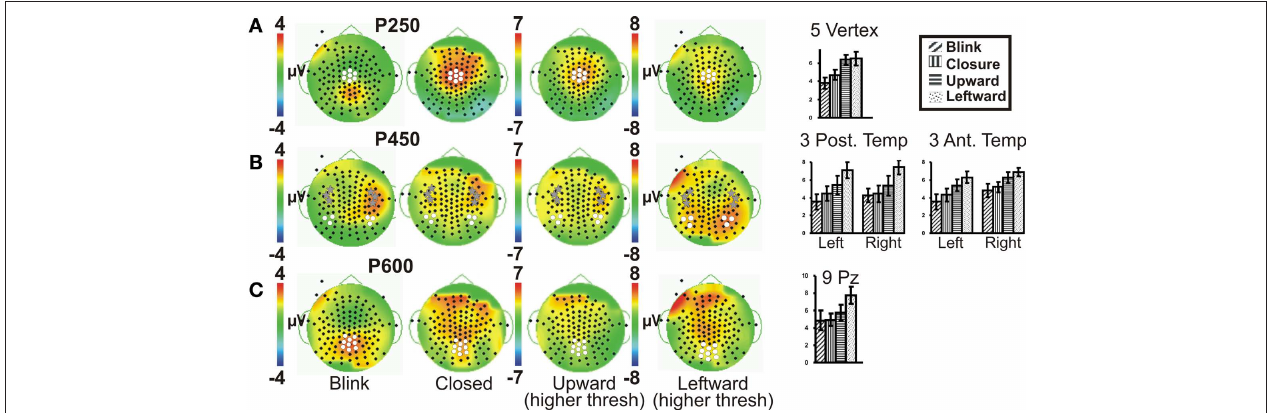
FiguRE 3 | group data: late ERPs. Topographic voltage maps for the Blink, Eye Closure (Closed), Upward and Leftward gaze conditions displayed, with Upward and Leftward gaze (right middle) displayed using a larger voltage scale. White dots on voltage topographic maps indicate electrodes used in ANOVAs and in